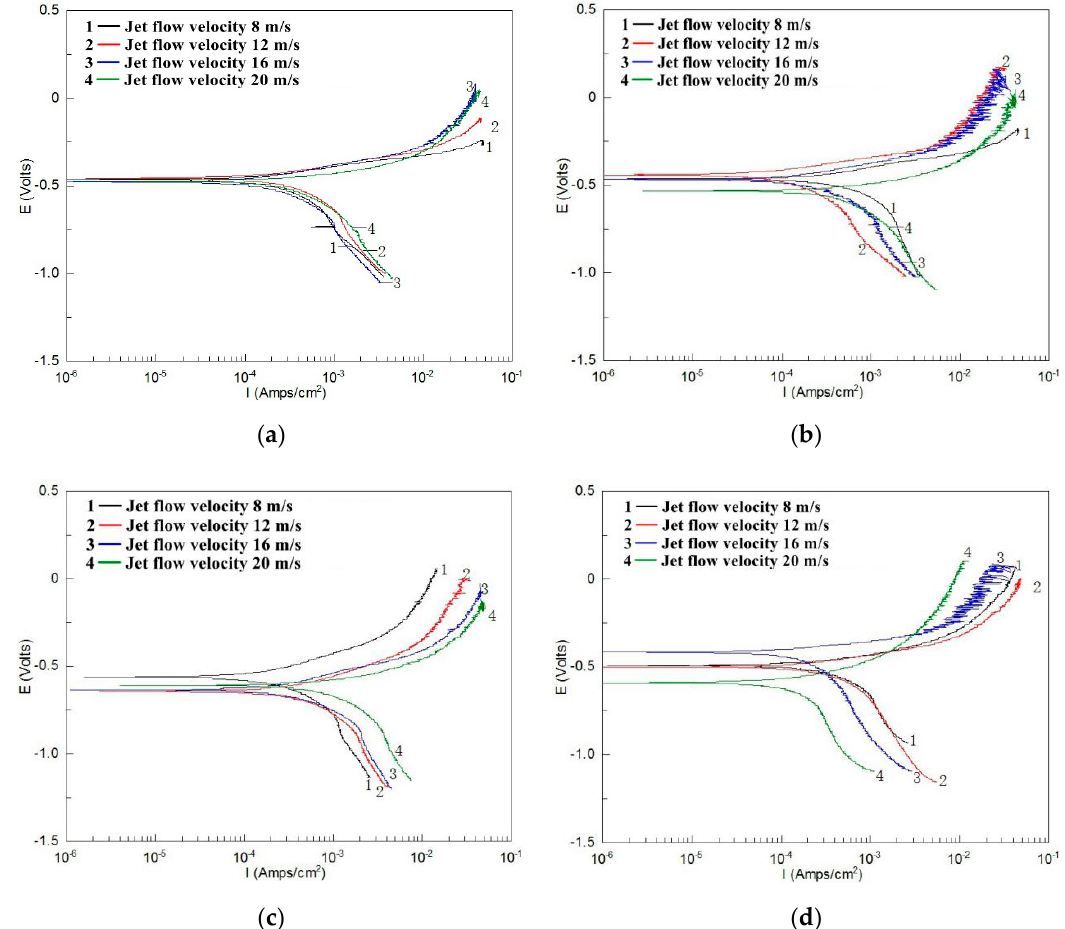
Figure 5 . Polarization curves of TP140 within an angle of 30° up to 90° (2 wt % NaCl + distilled water).